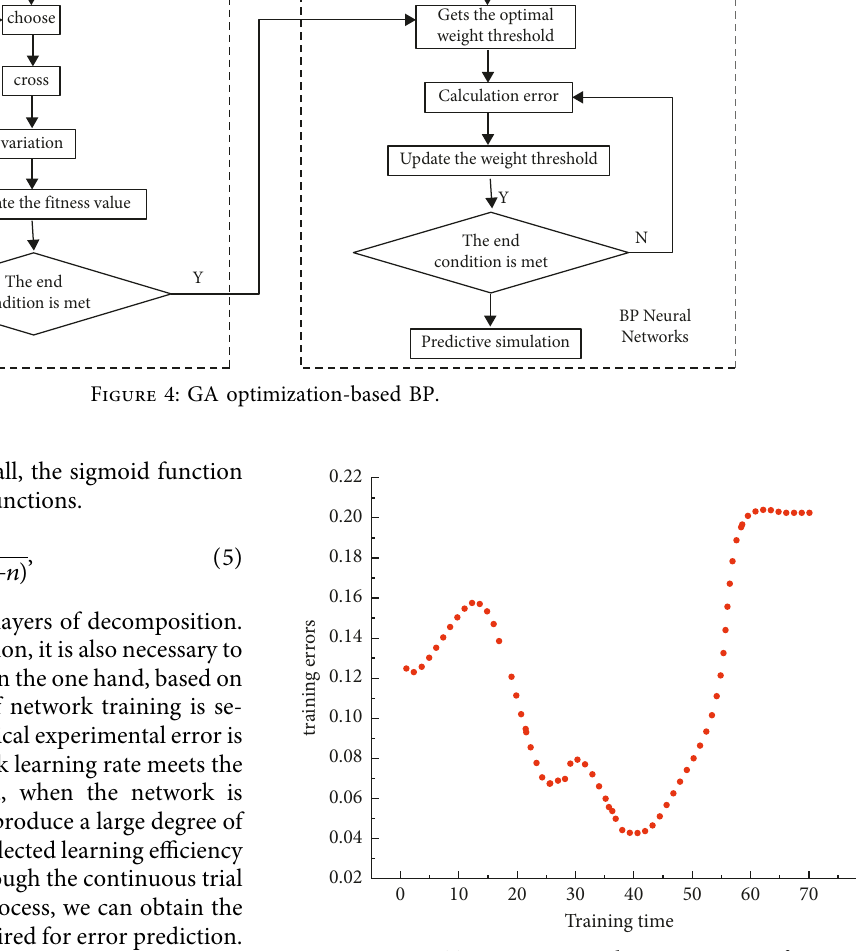
Figure 5: Training times and training errors of